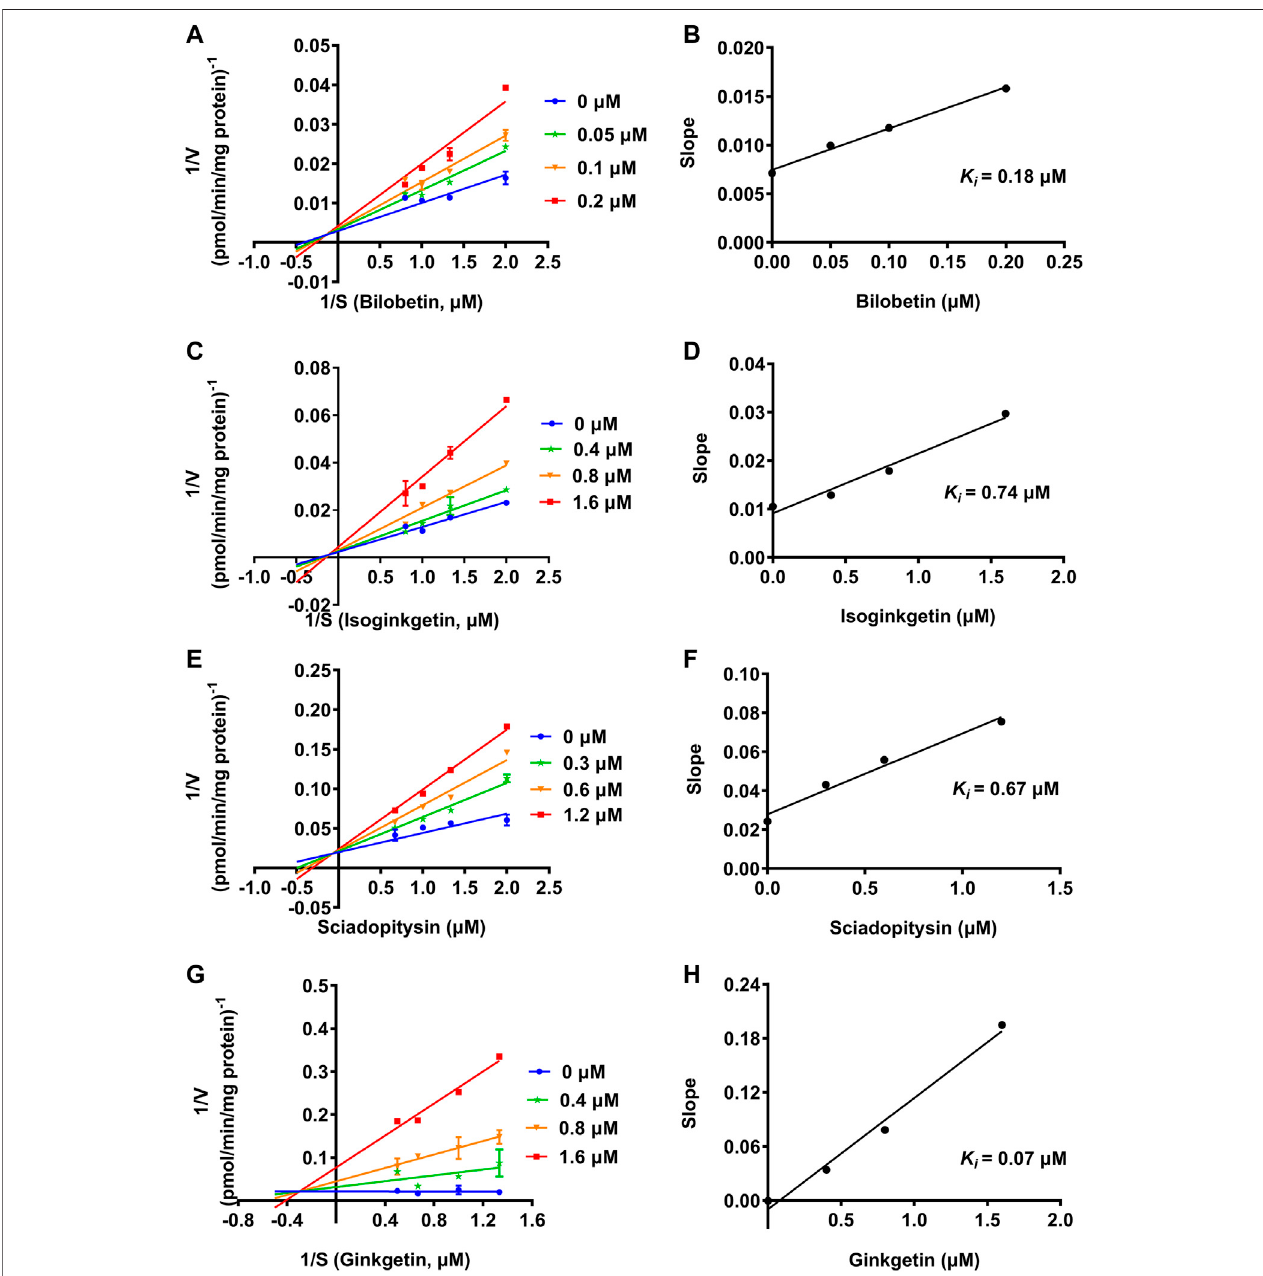
FIGURE5| Lineweaver-Burkplots (A,C,E,G) ofbilobetin,isoginkgetin,sciadopitysinandginkgetinagainstUGT1A1-catalyzedNHPN- O -glucuronidationinHLM, and the second plots (B, D, F, H) using the slopes obtained from the Lineweaver-Burk plots VS the concentrations of each inhibitor.